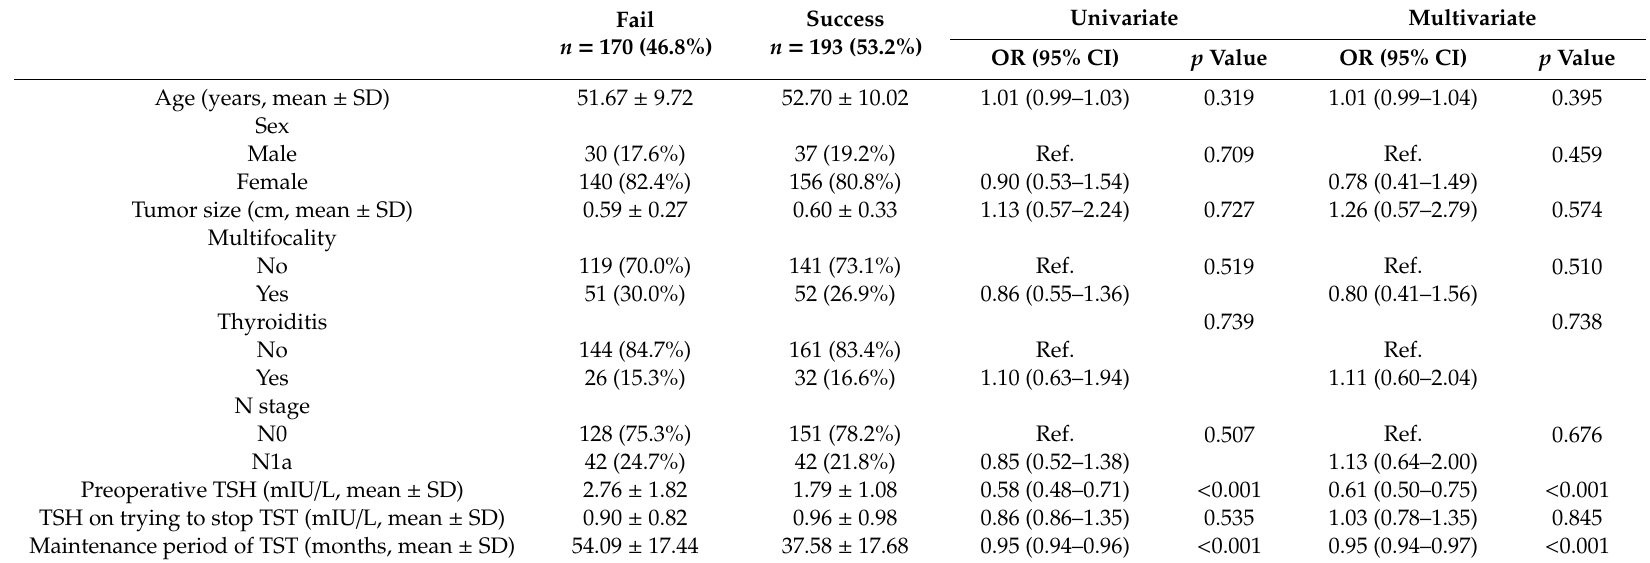
Table 2. Univariate and multivariate analysis for clinical factors associated with successful cessation of thyrotropin suppression